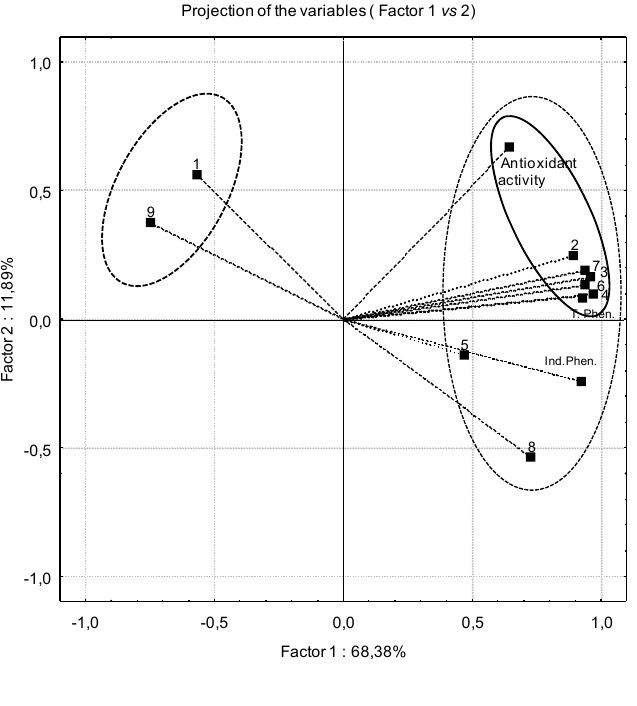
Figure 3. Multivariable analysis results: ( 1 ) gallic acid ( 2 ) chlorogenic acid; ( 3 ) caffeic acid; ( 4 ) cyanidin-3-glucoside; ( 5 ) quercetin-3- O -rutinoside; ( 6 ) Luteolin-4- O -glucoside; ( 7 ) caffeic derivatives; (8) quercetin-3- O -rhamnoside; (9)